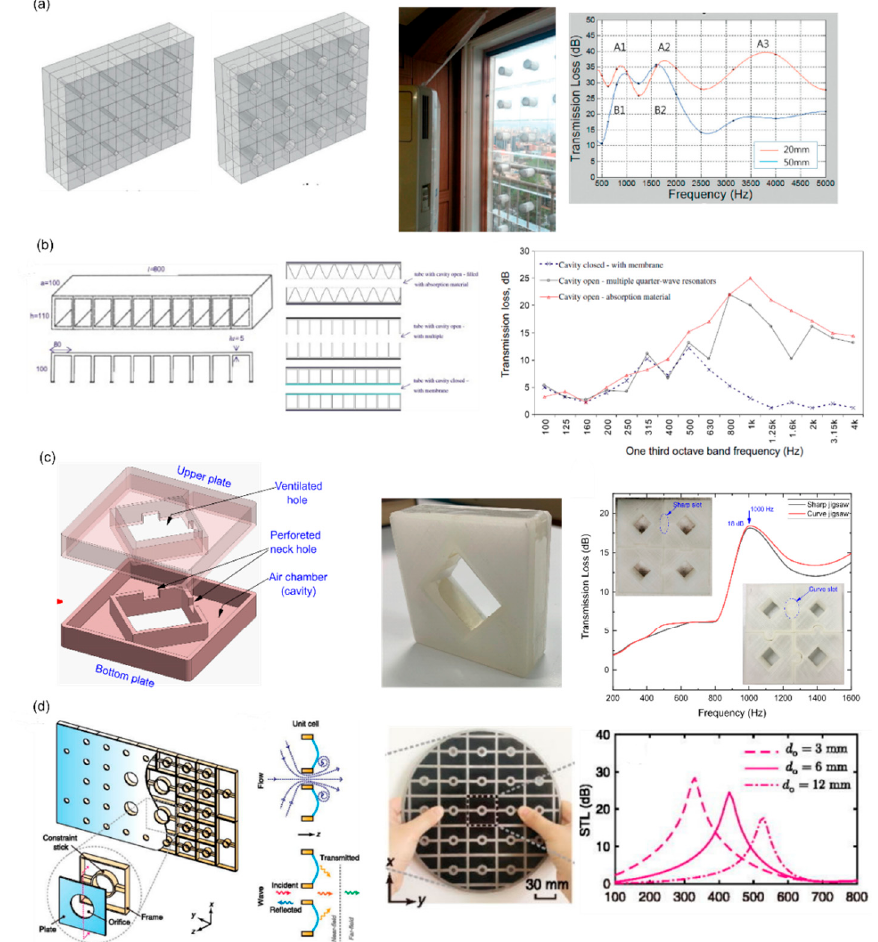
Figure 4. ( a ) Schematics of the proposed air transparent acoustic window panels (consisting of transformed resonators and air filters with hole diameters of 20 and 50 mm. The dimensions of each cell were 150 mm × 150 mm × 40 mm with a thickness of 5 mm of a transparent acrylic sheet). Photographs are of the installed window panel in building and their measured transmission loss spectra, which was about 30–35 dB in the range of 400–5000 Hz with the 20 mm window and about 20–35 dB in the range of 700–2200 Hz with the 50 mm window. Reprinted with permission from Kim and Lee [90], © 2014 Author(s), licensed under a Creative Commons Attribution 3.0 License. ( b ) 3D-view and top-view of the multiple quarter-wave resonators. Measured transmission loss spectra of three types of silencers are shown. Reprinted with permission from Wang et al. [91], © 2013 Elsevier Ltd. ( c ) Schematic details of ventilated metamaterial unit cell composed of two necks and a single chamber. A maximum transmission loss peak of around 18 dB was achieved from the proposed design. Reprinted with permission from Kumar et al. [94], © 2019 Elsevier Ltd. ( d ) Typical configuration of the perforated and constrained acoustic metamaterial and the measured transmission loss spectra. Reprinted with permission from Wang et al. [95], © 2019 AIP Publishing